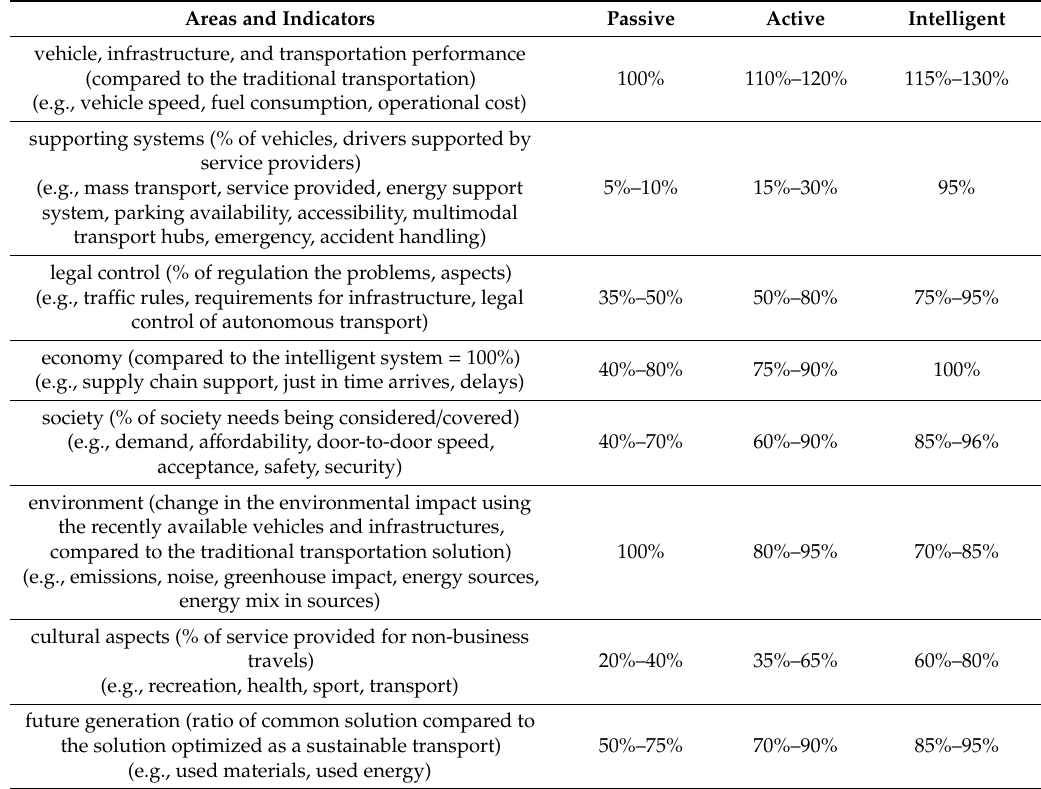
Table 1. Simplified comparative analysis of di ff erent transportation